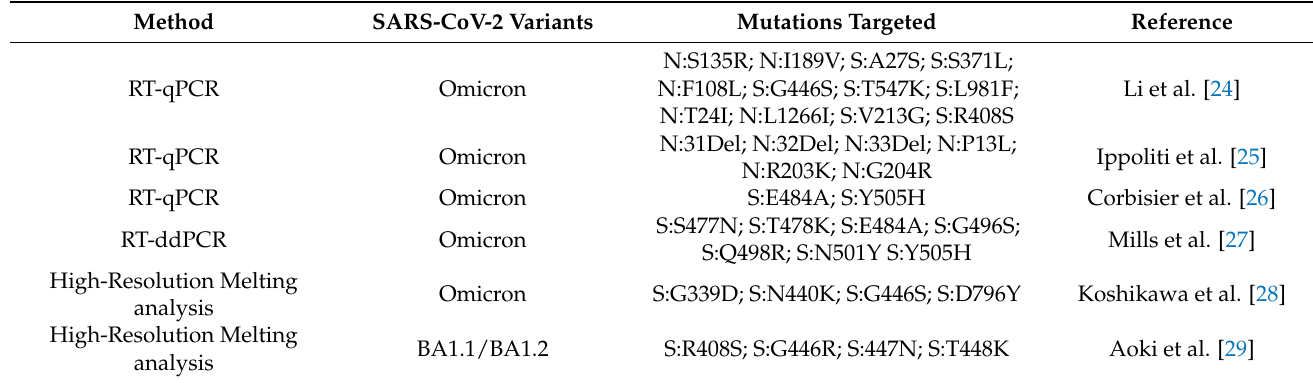
Table 1. Current assays for SARS-CoV-2 variant